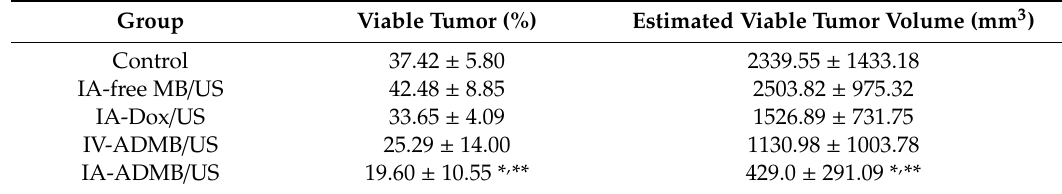
Table 2. The viable tumor percentage and estimated viable tumor volume of each